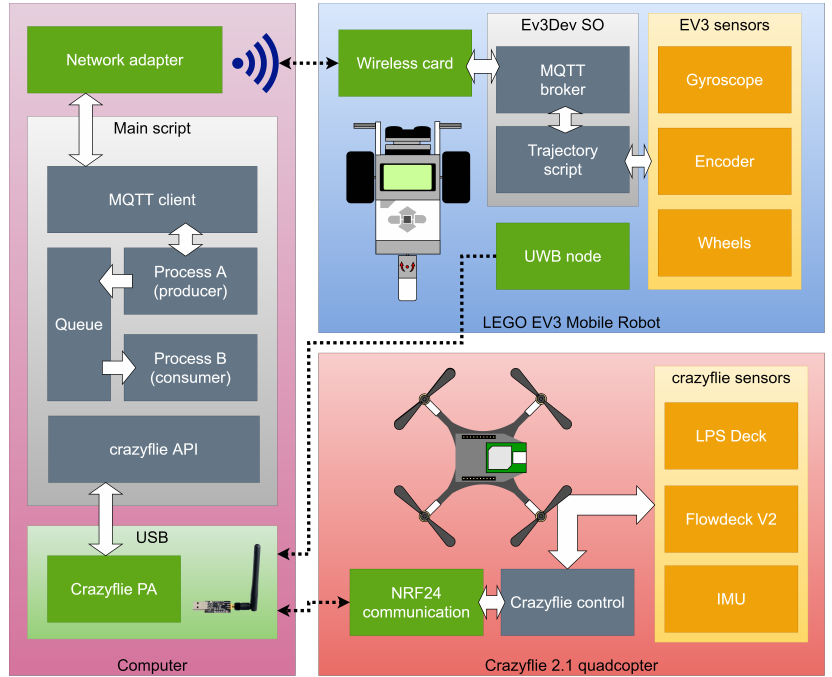
Figure 8. Block diagram illustrating the interaction between the components during the execution of the